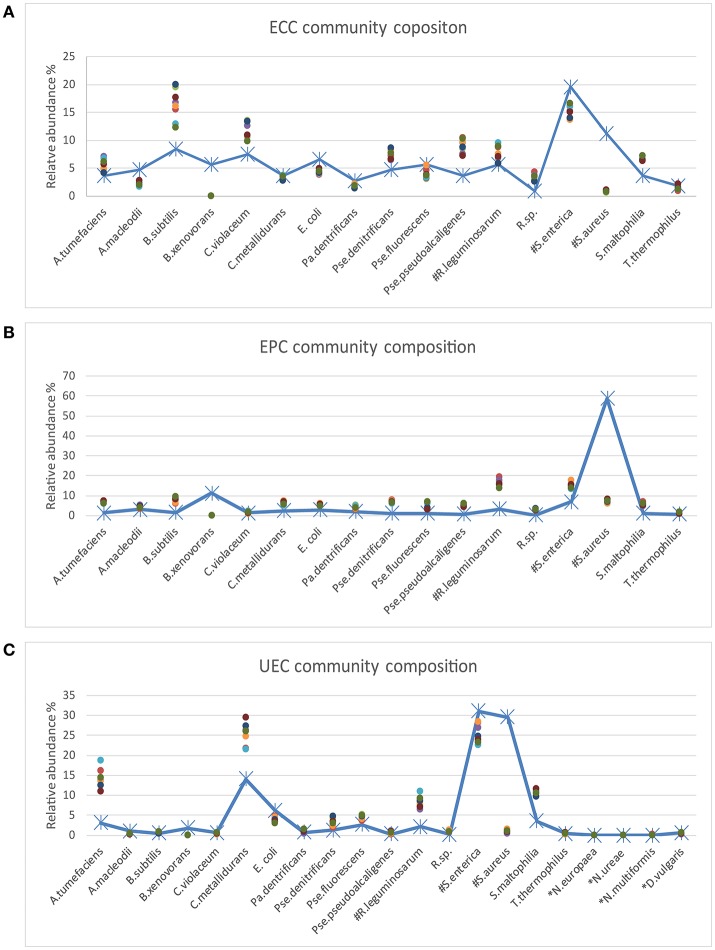
Comparison of the inferred and expected community composition. The line plots show the expected species abundance and the scatter plots show the observed abundance based on MetaAmp analysis of the MiSeq runs. Each point in the plot represents a biological or technical replicate. (A) ECC is the equal cell number community. In the ECC community, the same number of cells was added to the community for each strain. (B) EPC is the equal protein amount community. In the EPC community, the same amount of each strain was added to the community based on protein mass. (C) UEC is the uneven community. In the UEC community, the cell count or protein amount of the different strains cover a large abundance range. The species names starting with # indicate that multiple strains were added to the mock samples and the species names starting with * indicate that those species were only added to the UEC community and their DNA input abundance was very low. The expected relative abundance of each organism was corrected by the 16s rRNA gene copy number in each organism.